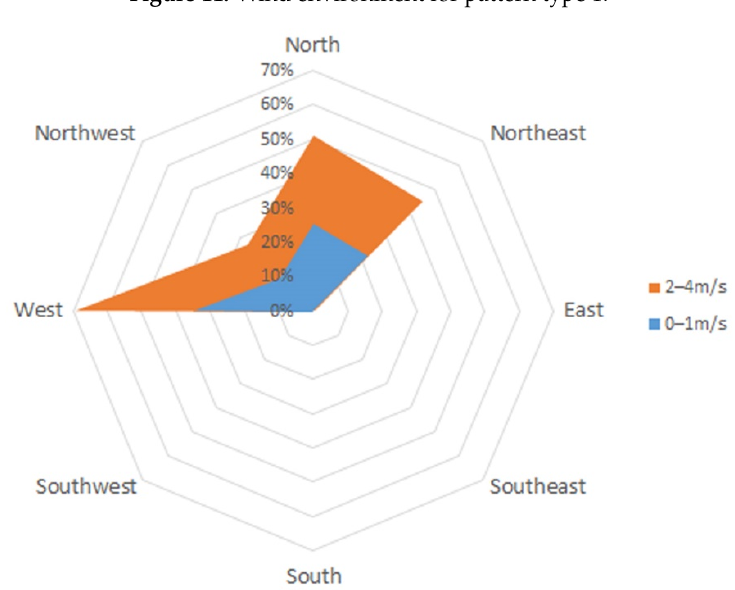
Figure 12. Wind environment for pattern type 3.